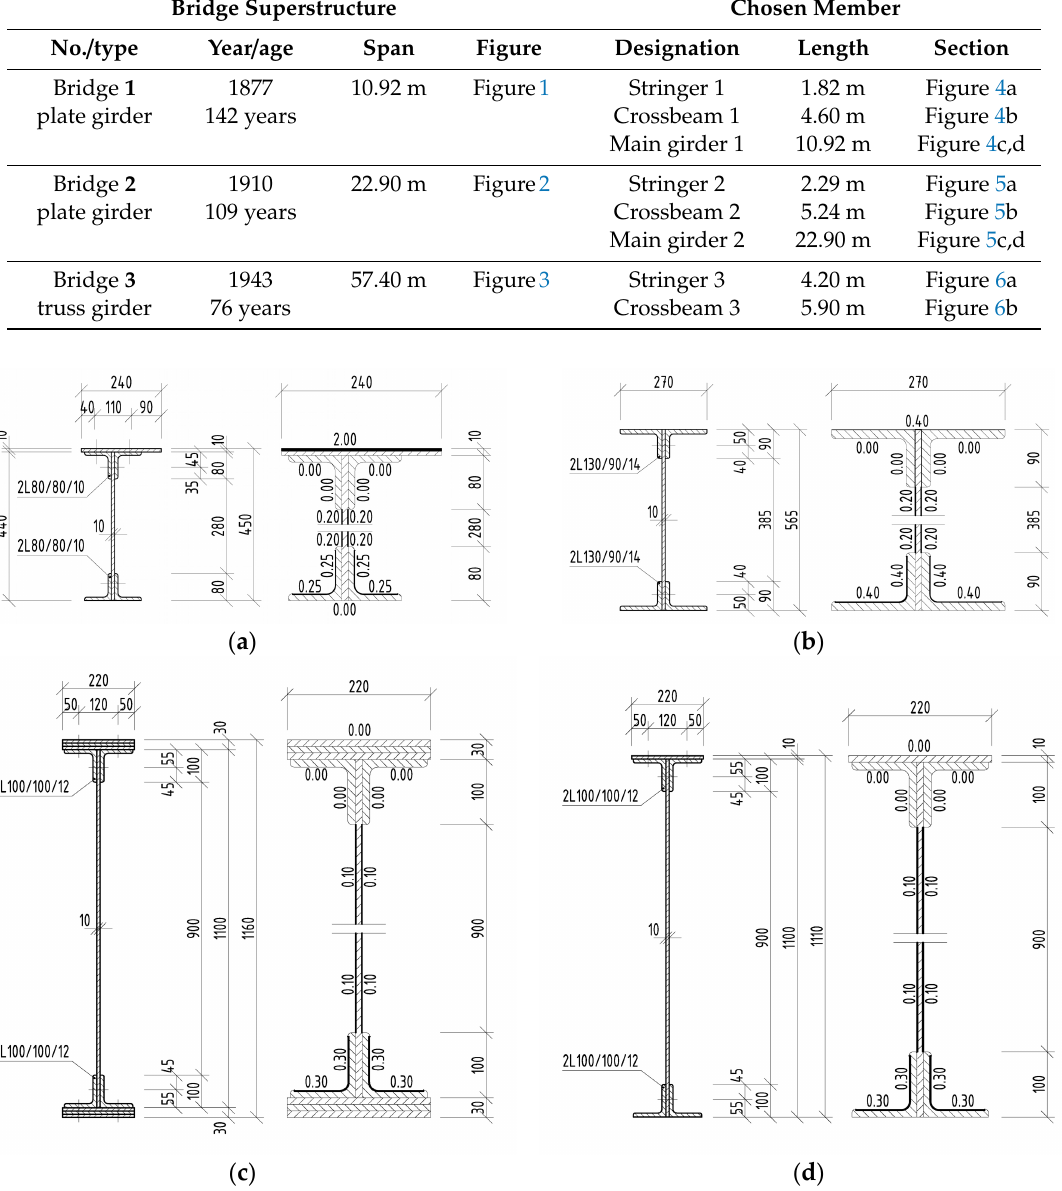
Figure 4. Riveted I-sections and average corrosion losses of elements in the case of Bridge 1: ( a ) left stringer; ( b ) crossbeam; ( c ) left main girder in the midspan; ( d ) left main girder in the support zone.